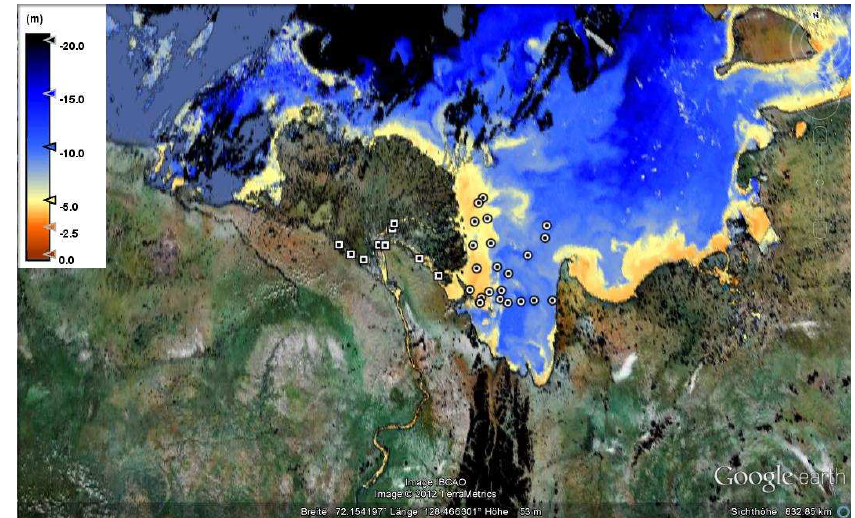
Figure 5 Fig. 5. Satellite image of 3 August 2012 from the ocean colour sensor MERIS indicating euphotic depth calculated as Z eu (λ) = 4 . 6 /k(λ)m , where k is the diffuse attenuation coefficient in the PAR